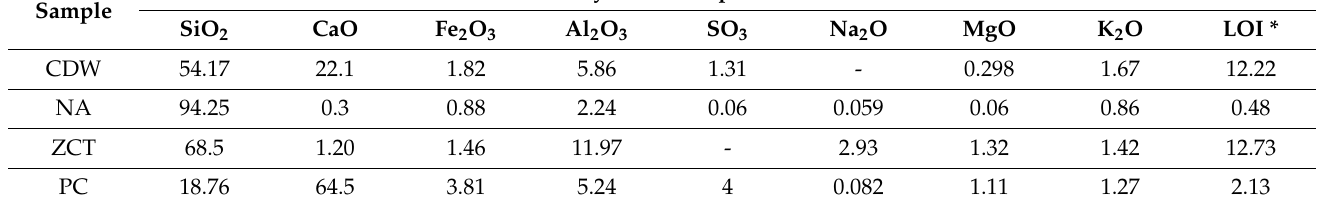
Table 3. Chemical composition of the samples investigated was determined by X ‐ ray fluorescence (XRF).